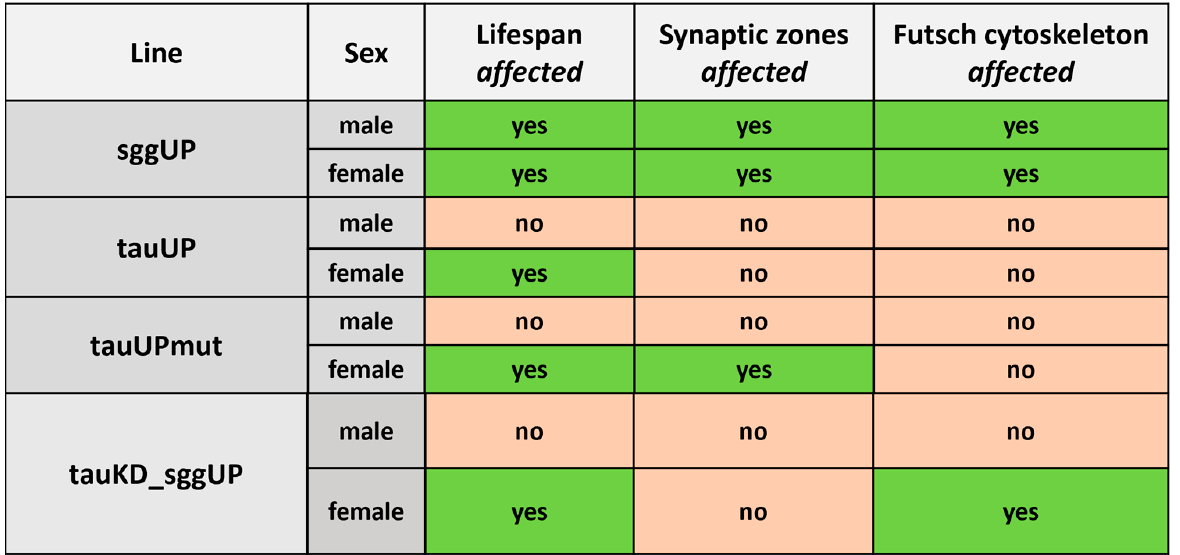
Figure 9. Effects of shaggy RB overexpression (according to [54]), tau RA overexpression, and tau knockdown in neurons on lifespan and the properties of the nervous system.